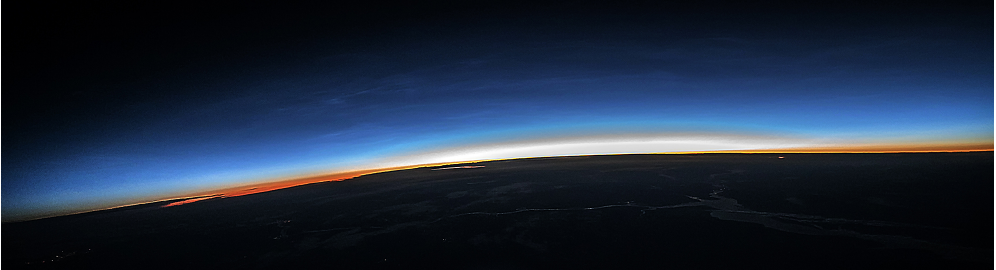
Figure 8. The SONC balloon image taken at 20.3km above the ground at 22:48UT on 5 July 2018 represents the final stage of NLC evolution on that